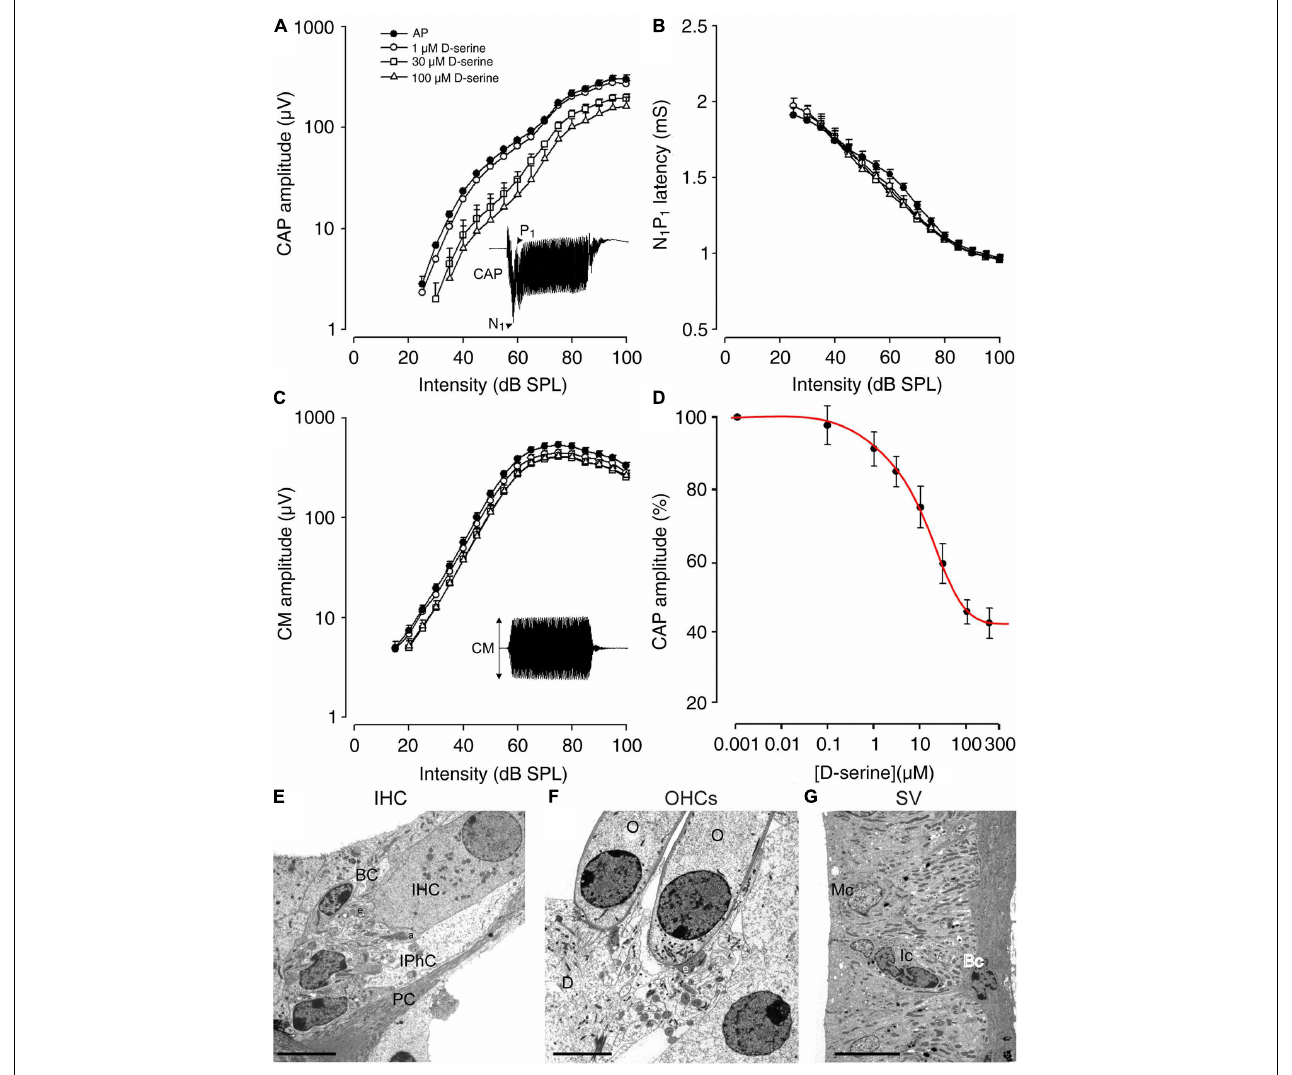
FIGURE 4 | Cochlear functional and morphological consequences of the effects of a 10 min intra-cochlear perfusion of D -serine in adult guinea pig. (A–C) Shown are the changes on input–output functions of the compound action potential (CAP), N 1 latency, and cochlear microphonic (CM) evoked by 8 kHz tone-bursts following either the control perfusion of artificial perilymph (filled circles), 1 µ M D -serine (open circles), 30 µ M D -serine (open squares), or 100 µ M D -serine (open triangles). All points represent mean ± S.E values calculated from five animals. Note that D -serine caused a dose-dependent reduction in CAP amplitude (A) but no significant change in N 1 latency (B) or CM (C) . (D) Shown is a dose-response curve for D -serine. The dose-response data obtained was fitted to a curve using a non-linear least-squares logistic equation. The IC 50 value for D -serine was calculated to be 75 µ M. Note that saturating effects of higher doses of D -serine, i.e., 100 and 300 µ M were observed, leading to a limited reduction of CAP. (E) Shows a high magnification of the basal pole of the sensory inner hair cell (IHC) surrounding by the border cell (BC) and the inner phalangeal cell (IPhC) close to the pillar cell (PC). Note that the afferent (a) and the efferent nerve endings (e) appear normal. (F) Shows a high magnification of normal basal poles of two outer hair cells (O) in contact with one larger efferent terminal (e); Deiters’ cell (D) . (G) No pathological damage was observed in the organization of the stria vascularis; Marginal cell (Mc); Intermediate cell (Ic); Basal cell (Bc). Scale bars: (E,F) = 5 µ m, (G) = 10 µ